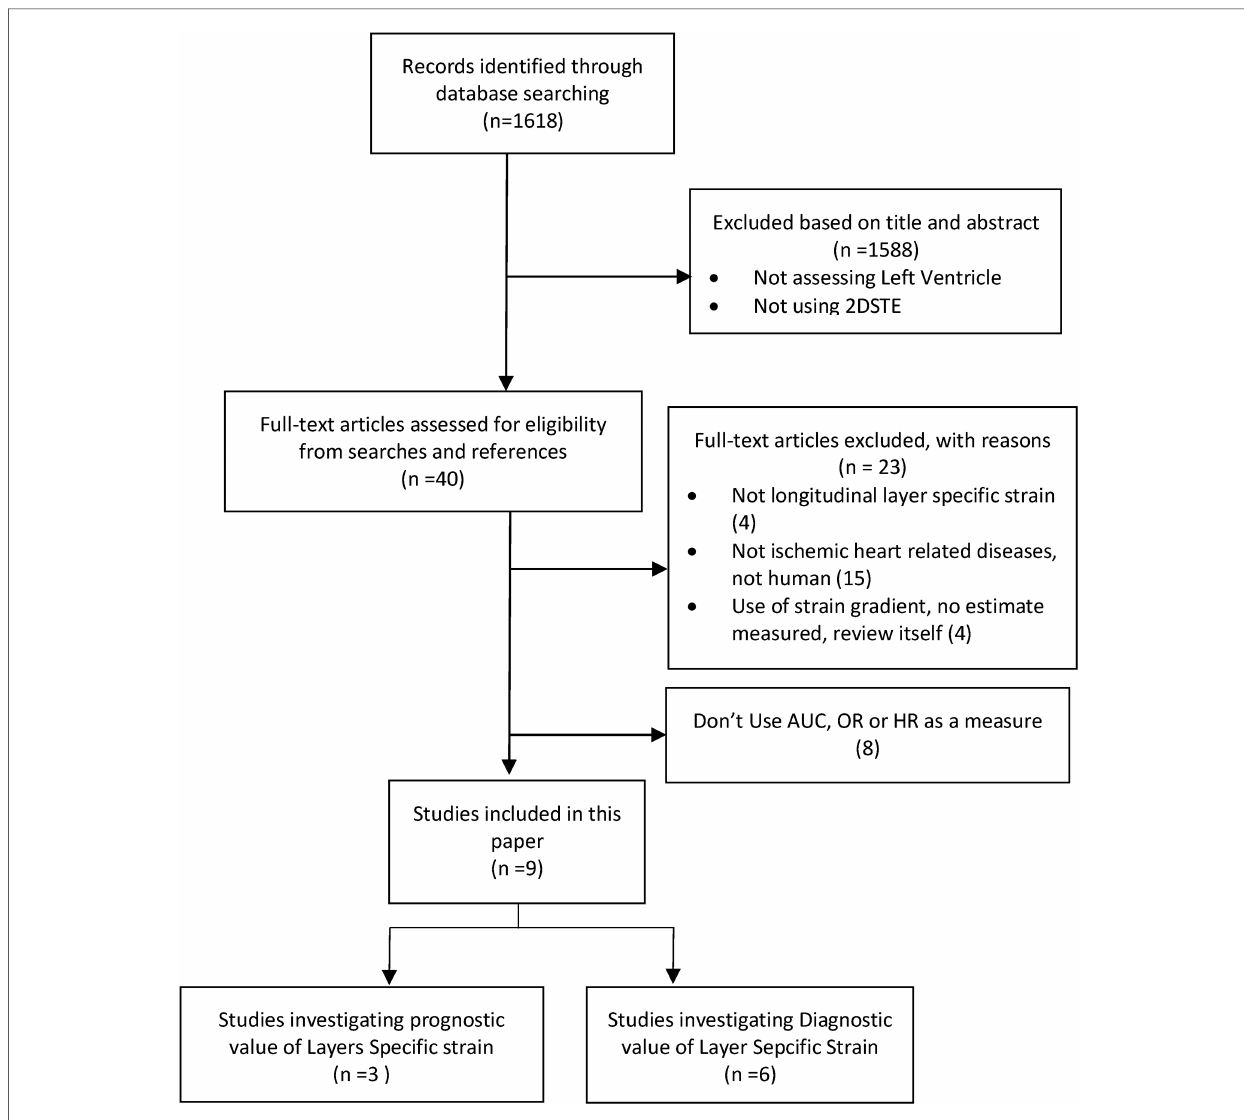
FIGURE 1 PRISMA fl ow diagram. PRISMA fl ow diagram displaying process of fi nding eligible studies for this review. Abbreviations: PRISMA, preferred reporting items for systematic review and